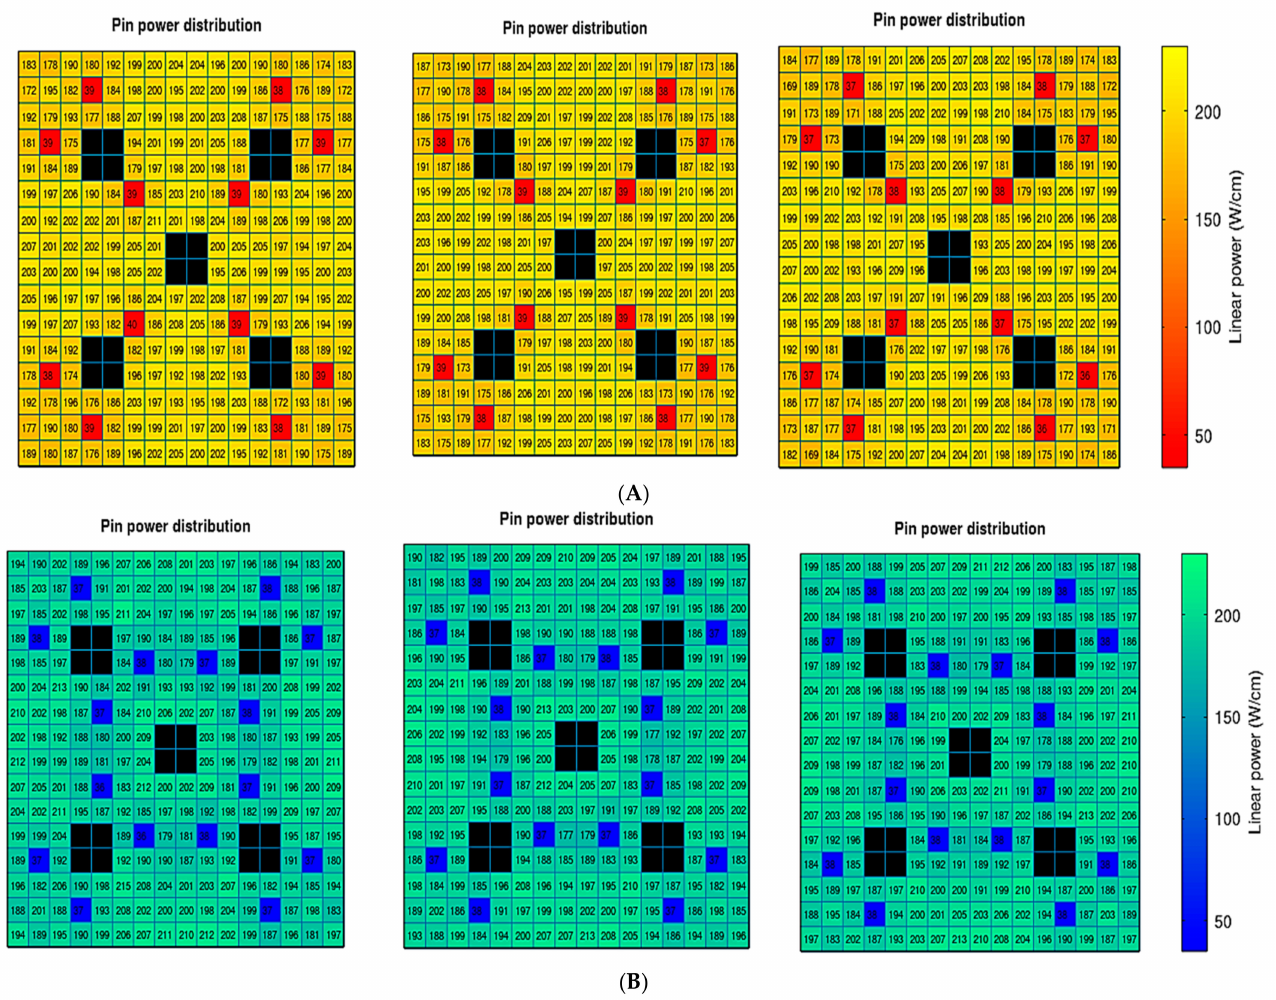
Figure 10. Power profile at BOC for B1 and C1 assemblies type for different fuel cladding sys- tems. ( A ) B1 − zircaloy, B1 − SiC, and B1 − FeCrAl, respectively. ( B ) C1 − zircaloy, C1 − SiC, and C1 − FeCrAl,